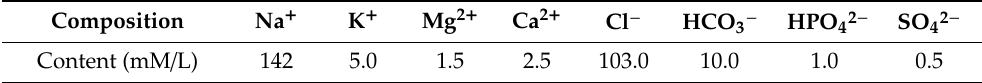
Table 3. Composition of simulated body fluid.